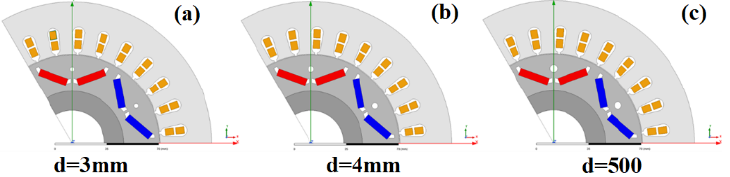
Figure 8. Rivet hole with center coordinates of (0,50) and diameters of: ( a ) d = 3 mm, ( b ) d = 4 mm and ( c ) d = 5 mm.